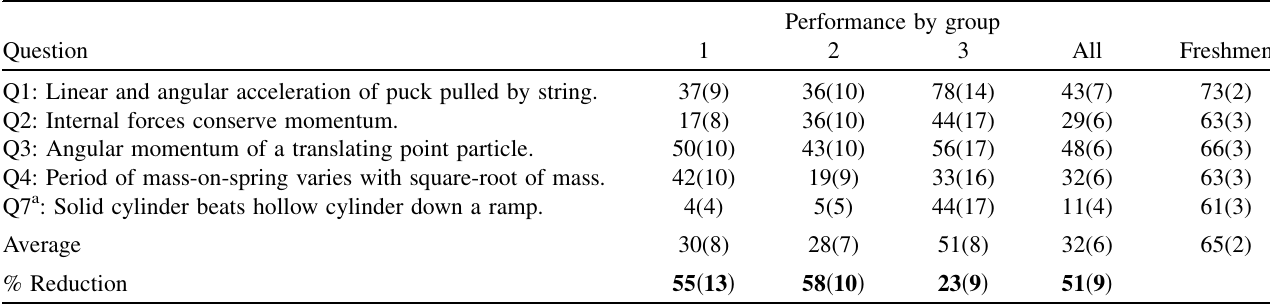
TABLE V. Performance of seniors and (different) freshmen on five multiple-choice questions covering advanced topics. The scores are percentages, with 1 (cid:2) errors in parentheses. Percent reduction is the reduction of the freshman average that would be required to yield the relevant senior average.